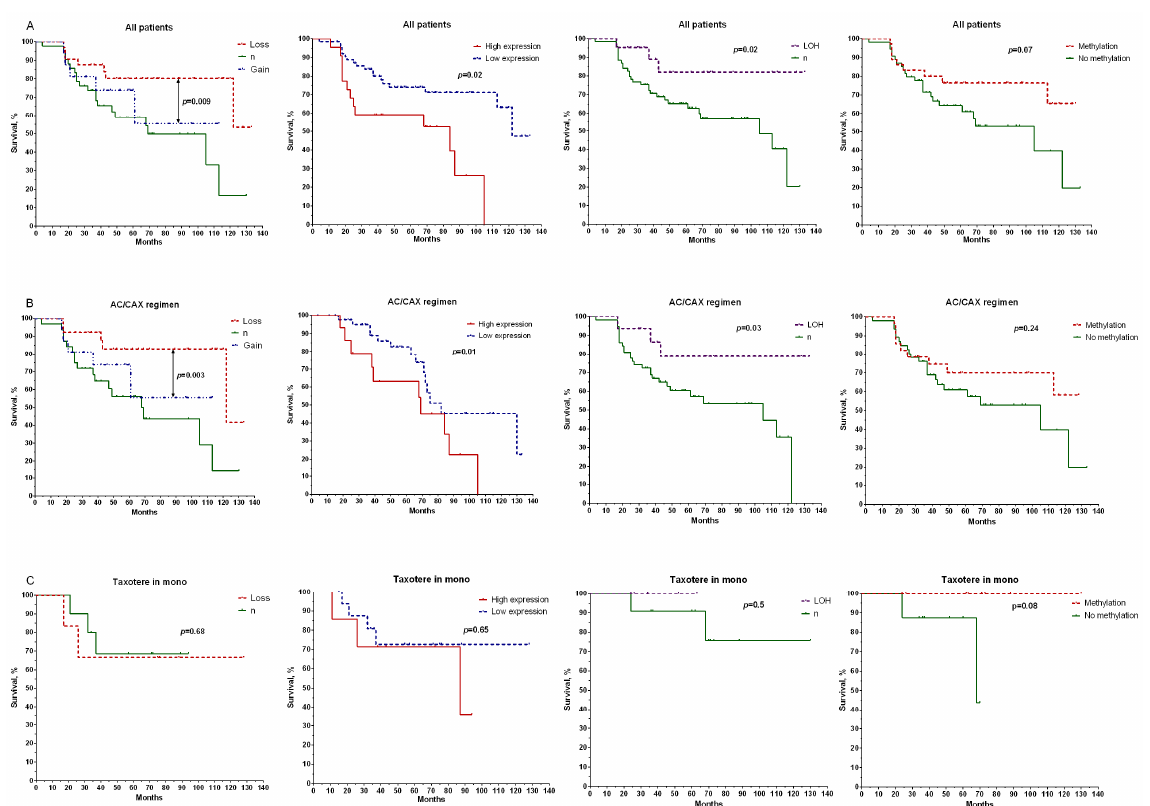
Figure 2. Relationships between CNA, gene expression, sites of loss of heterozygosity, and methyla- tion of the promoter region of the BRCA1 gene with metastatic-free survival in the general group of patients ( A ), patients treated with anthracycline-containing regimen (AC/CAX) ( B ), and patients treated with taxotere monotherapy ( C ). Note: a log rank test was used to compare significance of differences among groups in terms of